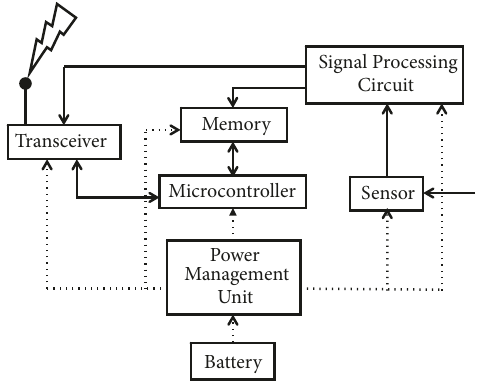
Figure 2: Layout of a wireless sensor